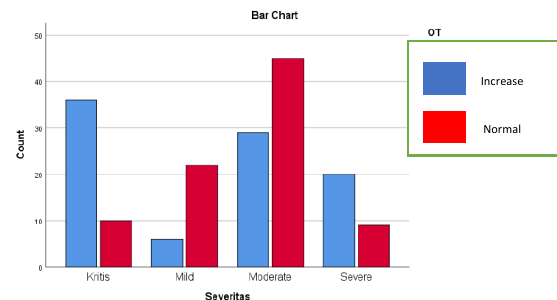
Figure 1. Diagram of the Relationship between Elevated AST and Severity